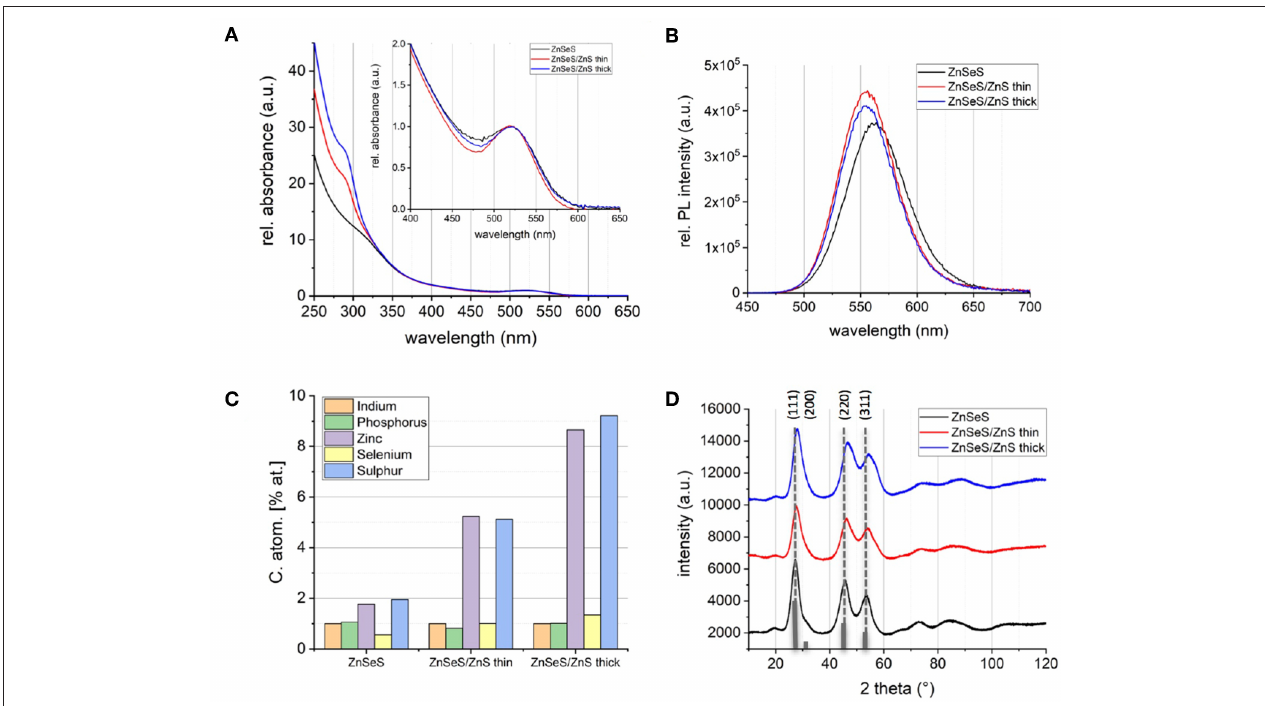
FIGURE 2 | Normalized absorbance spectra (A) and absorbance corrected PL spectra (B) of InZnP QDs with ZnSeS (black), ZnSeS/ZnS thin (red), and ZnSeS/ZnS thick shell (blue). (C) Indium normalized composition determined with EDX. (D) Powder X-ray diffractograms (Cu-K α ); the reference pattern of bulk zinc blende InP (JCPDS file #32-0452) is added as gray